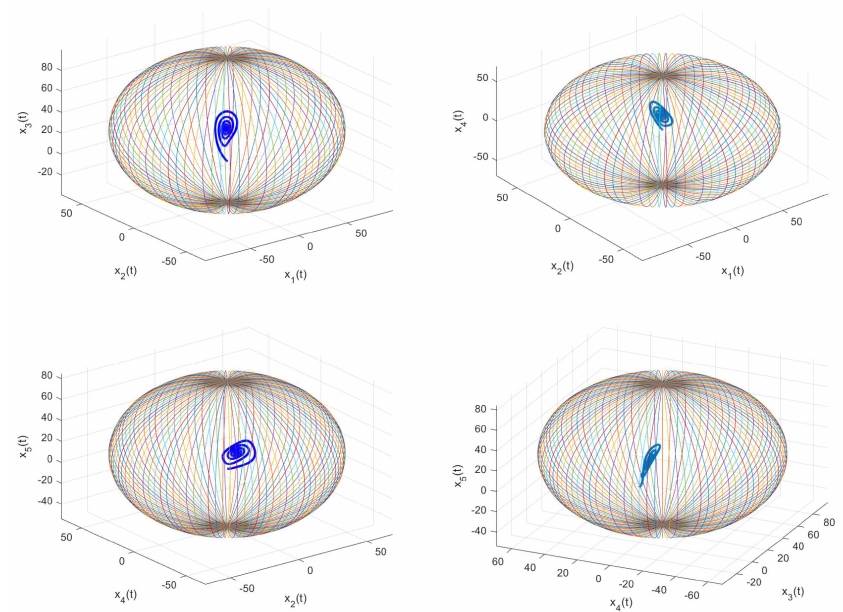
) of system (13), where σ = 10, b = 8 U 1,2